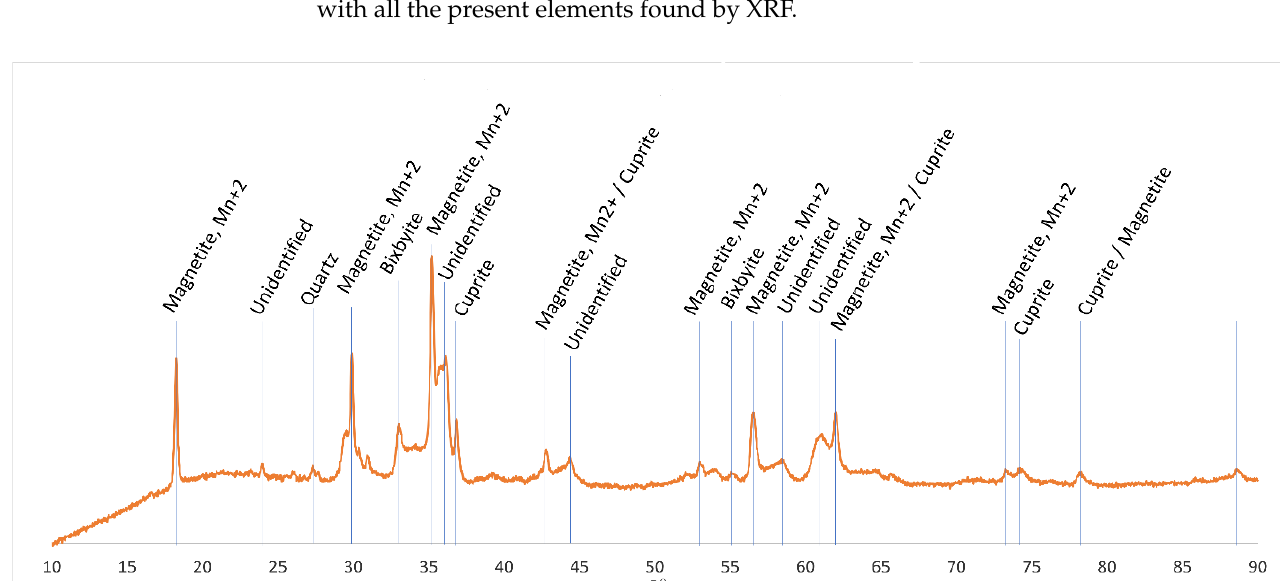
Figure 8. The stacked XRD patterns of PMMN samples reduced by different gases with their iden- tified peaks. 3.2.3. Microstructural Changes A typical SEM image of a calcined PMMN in Figure 9 shows a large pore volume evolution due to calcination. Obviously, there is less visible layered structure than that observed in the raw ore (Figure 4). Figure 9 also shows the distribution of the elements in different phases by BEI and elemental EDS mapping and have correlation with the obser- vations in the ore.